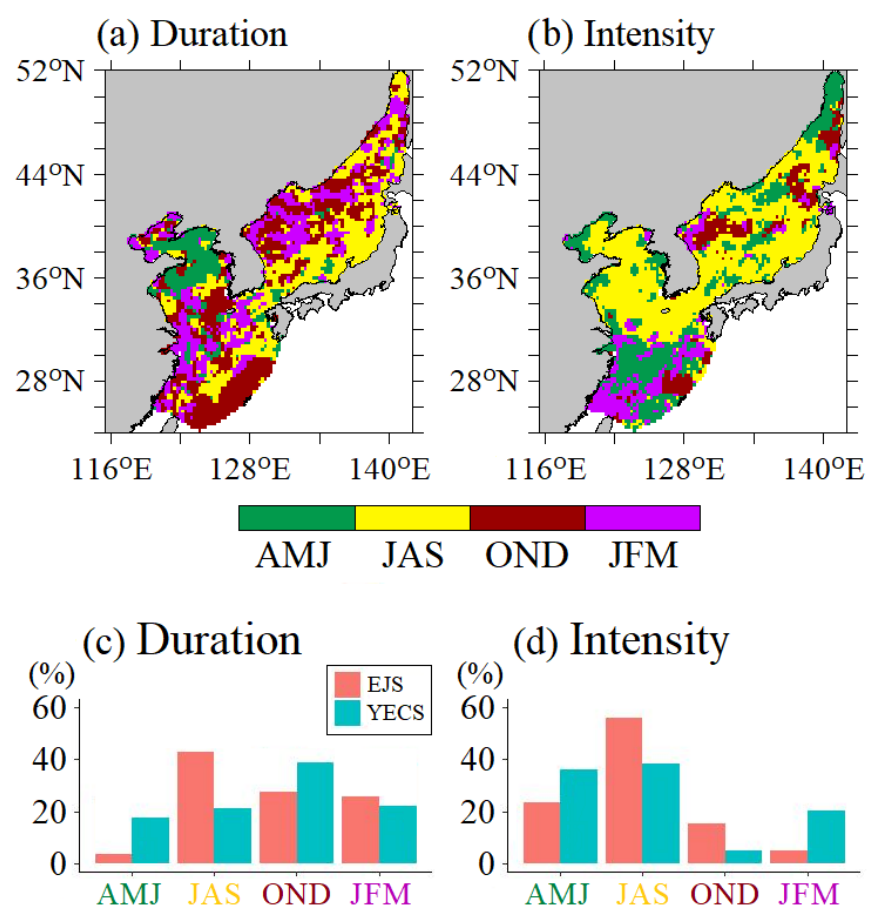
Figure 5. Spatial distribution (upper panels) and spatial ratio (bottom panels) of the season when MHWs have the longest duration ( a , c ) and strongest mean intensity ( b , d ).